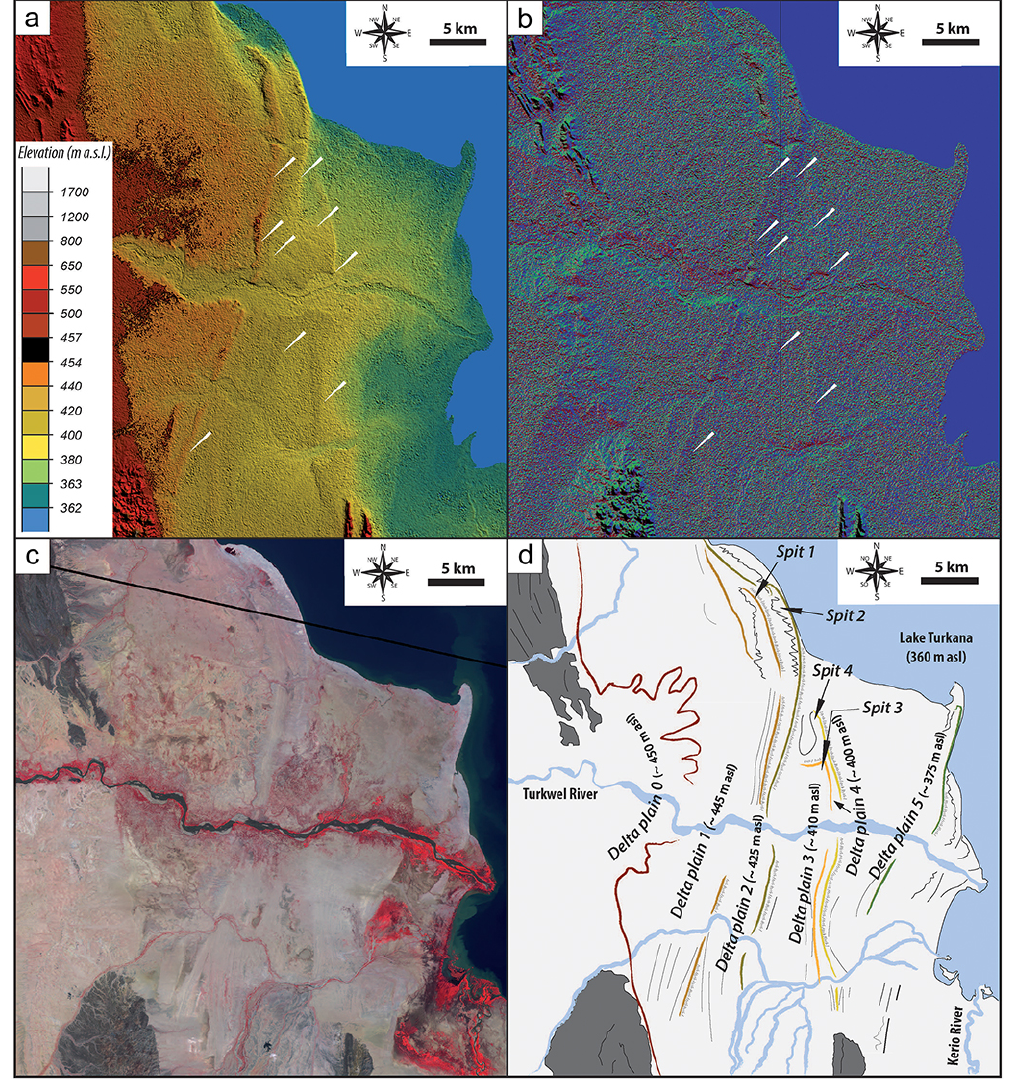
Figure 2. Turkwel delta complex. For location, see Fig. 1b. (a) Raw digital elevation model SRTM1 of the Turkwel delta. (b) Slope direc- tion shading applied to the DEM SRTM1 of the Turkwel delta to highlight the steps separating the different plateaus. Markers display the correspondence between (a) the DEM SRTM1 and (b) the slope direction shading. (c) SPOT5 satellite image of the Turkwel delta. (d) Inter- pretative geomorphological map of the area showing five successive delta plains in addition to the oldest plain associated with the late AHP